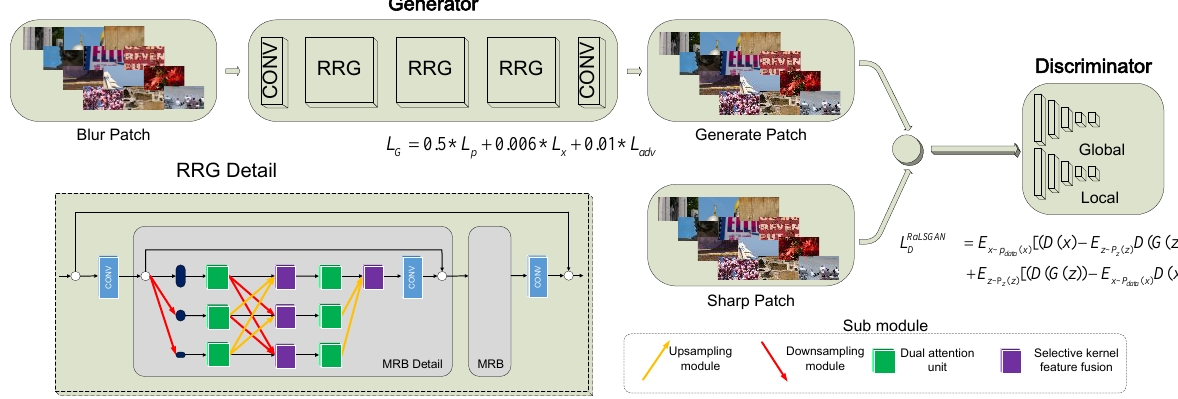
Figure 3. The RRG-GAN network architecture. (* denotes the multiplication